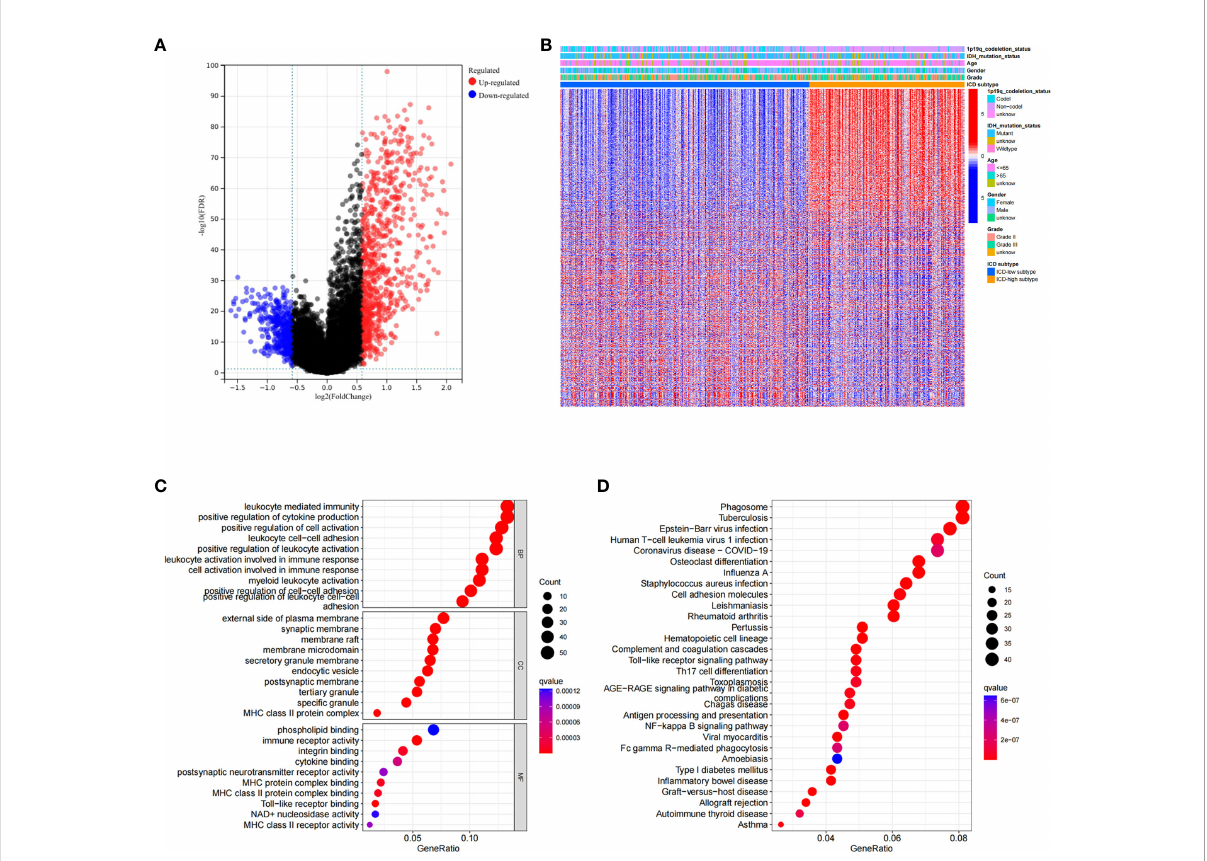
FIGURE 3 Analysis of differentially expressed genes (DEGs) and functional enrichment analysis in different ICD subtypes. (A) Volcano plot of the distribution of DEGs between ICD-high and ICD-low subtypes in TCGA cohort. (B) Heatmap of the DEG expression between ICD-high and ICD-low subtypes. (C, D) Dots plot of the KEGG (C) and GO (D) enrichment analysis. The size of the dot represents the gene count, and the colour of the dot represents the q